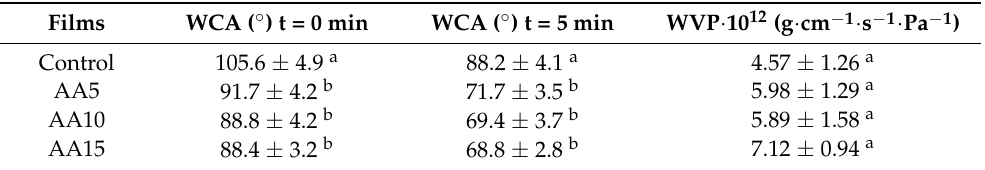
Table 4. Water contact angle (WCA) and water vapour permeability (WVP) values of WPI films as a function of ascorbic acid (AA)